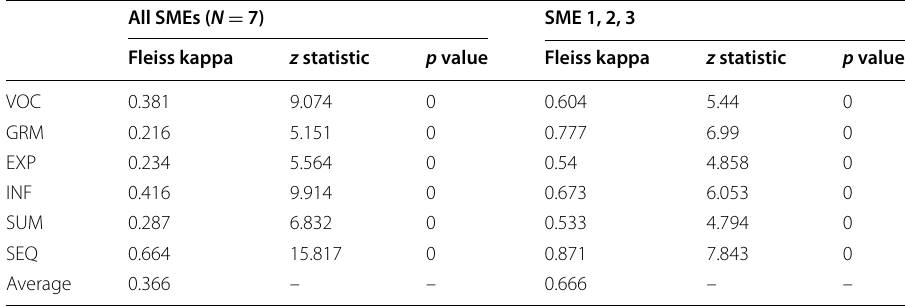
Table 6 Attribute-level agreement rate among